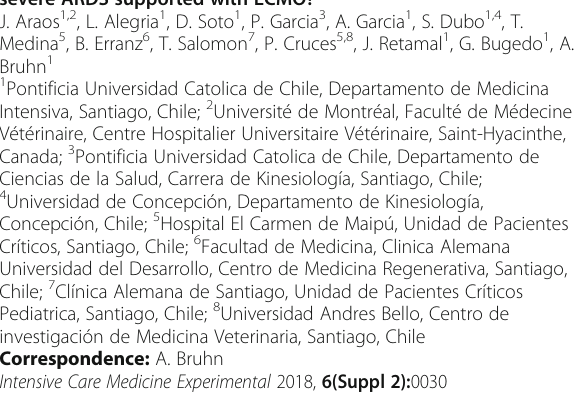
Fig. 1 (abstract 0029). Forest plot